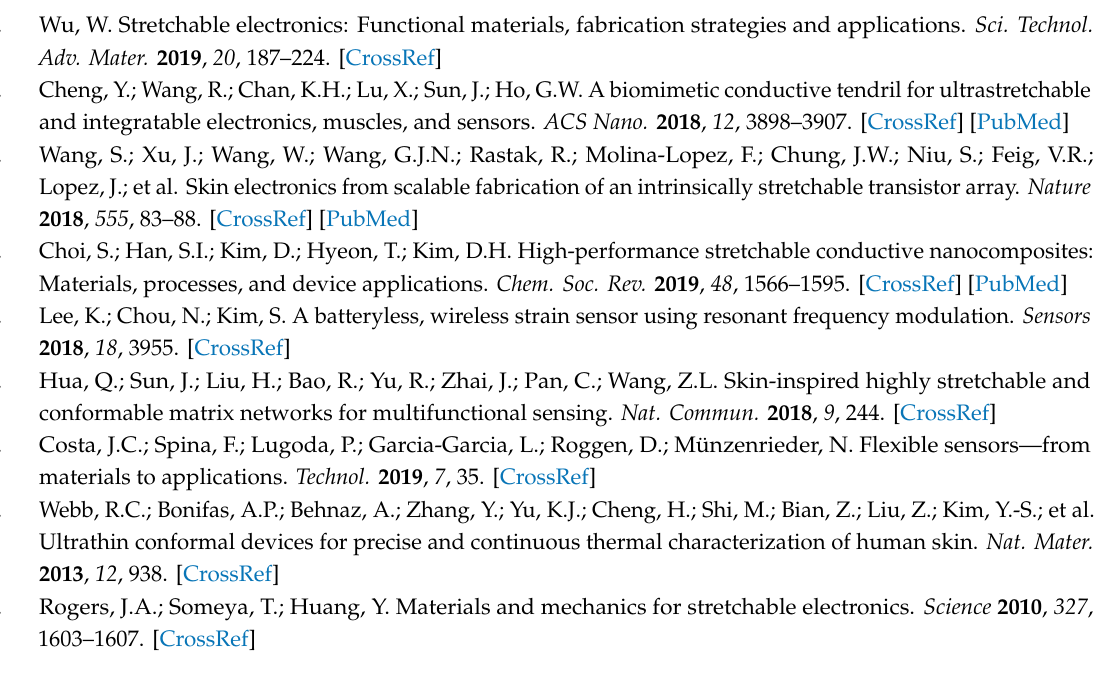
Figure S1: Detailed fabrication processes for the CNT-based sensor with meniscus-dragging deposition (MDD), Figure S2: Cross point analysis for quantitative analysis of the crack, Figure S3: Elastomer cracks and contact angles for specific conditions, Figure S4: Cross sectional image of double elastomer layer, Figure S5: Comparison of S unit along the X and Y-axis, Table S1: Numeric data for contact angles from the O 2 plasma treatment time, Table S2: Numeric data for contact angles after 15 min and 30 min, Table S3: Numeric data for cross points of the crack lines depending on O 2 plasma treatment time and substrate ration, Table S4: Thickness of double elastomer